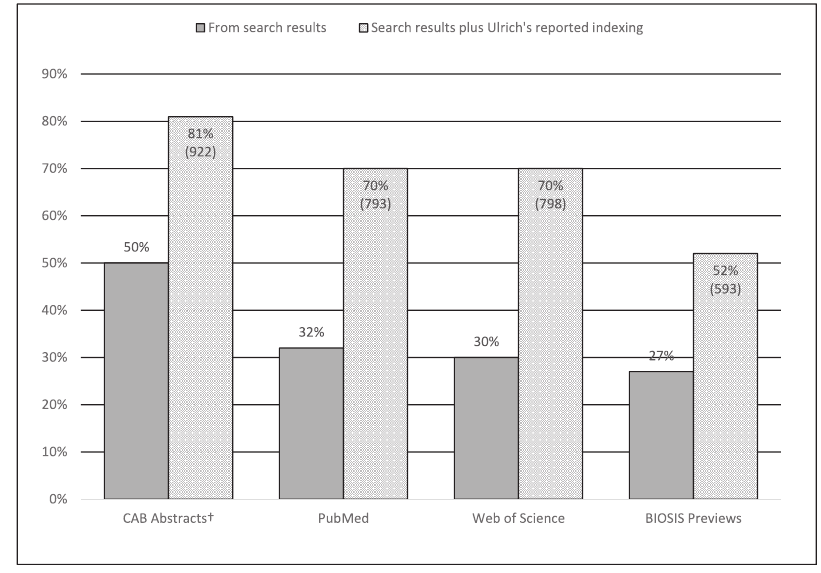
Figure 1 Database indexing coverage* of the One Health journals in this data set (n ¼